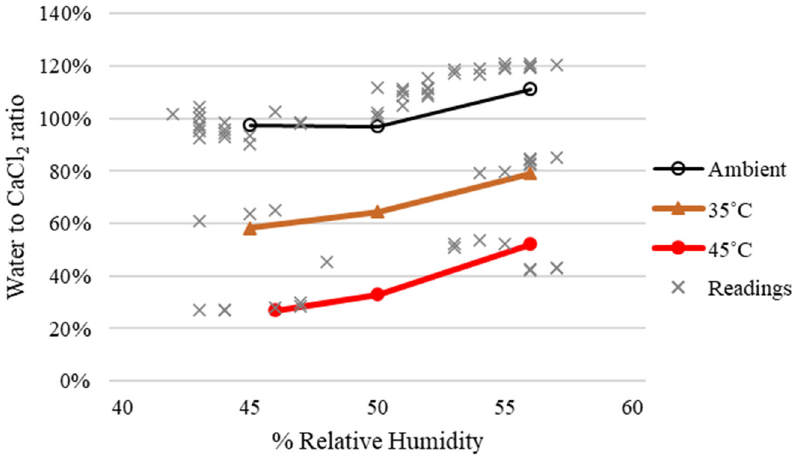
Figure 9. Average CaCl 2 water content against % relative humidity at different solution temperatures (ambient temperature = 25 ± 2 °C).